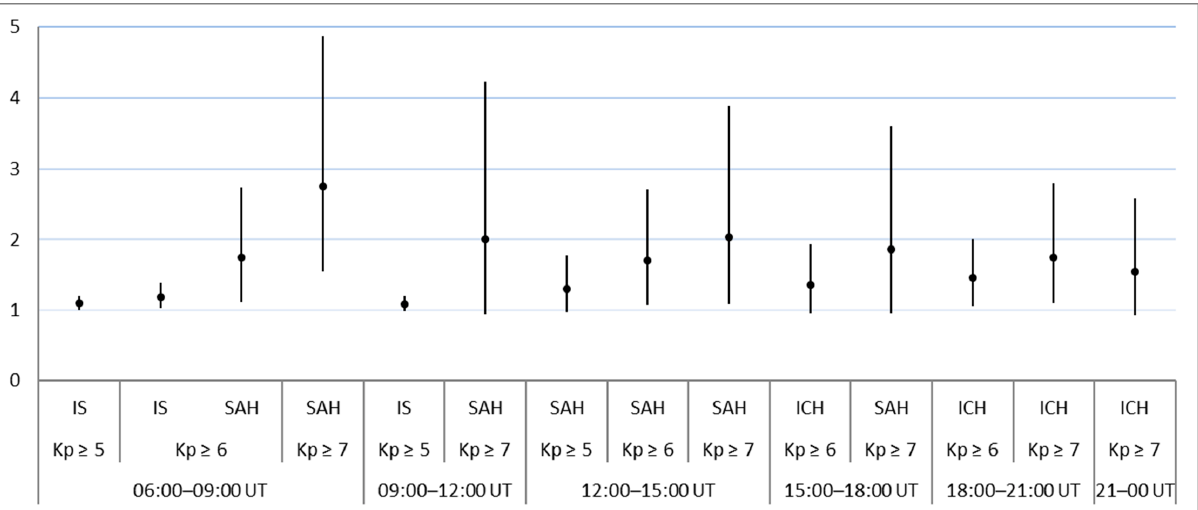
Figure 1. Univariate associations between GS occurring at different times (UT) and the risk of stroke (Rate ratio with 95% CI).